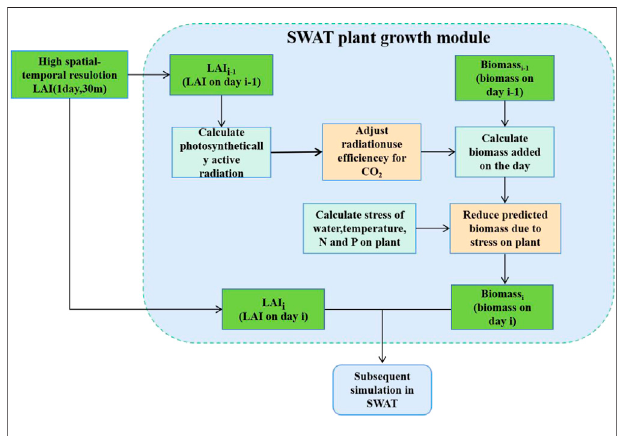
FIGURE 3 | The modi fi ed plant growth